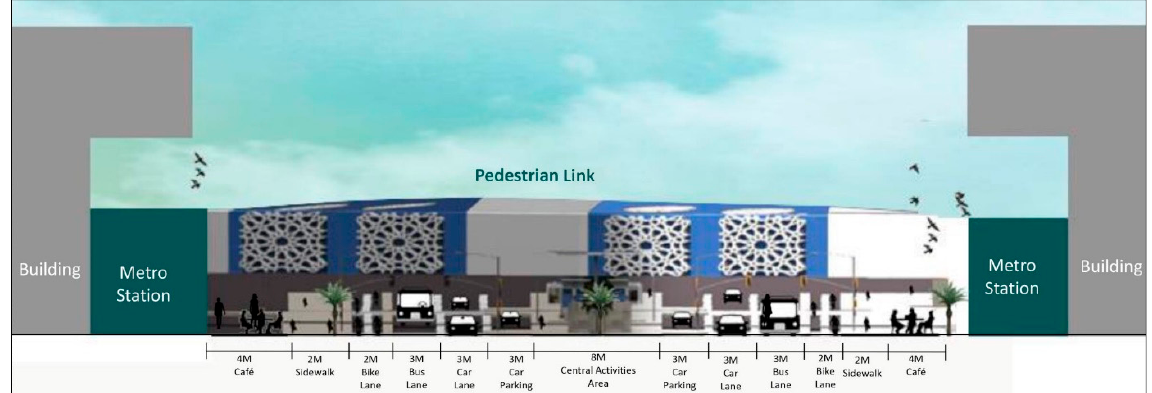
Figure 25. New proposed street cross section, aiming to achieve a multimodal transportation system that is integrated with outdoor spaces (Source: the Authors).